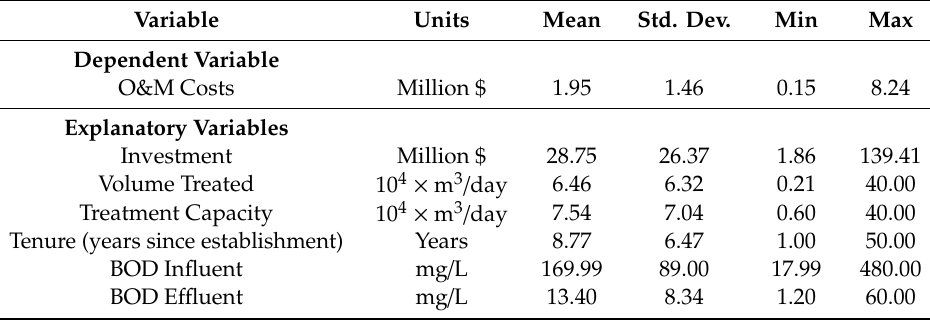
Table 1. Descriptive statistics of the cost model